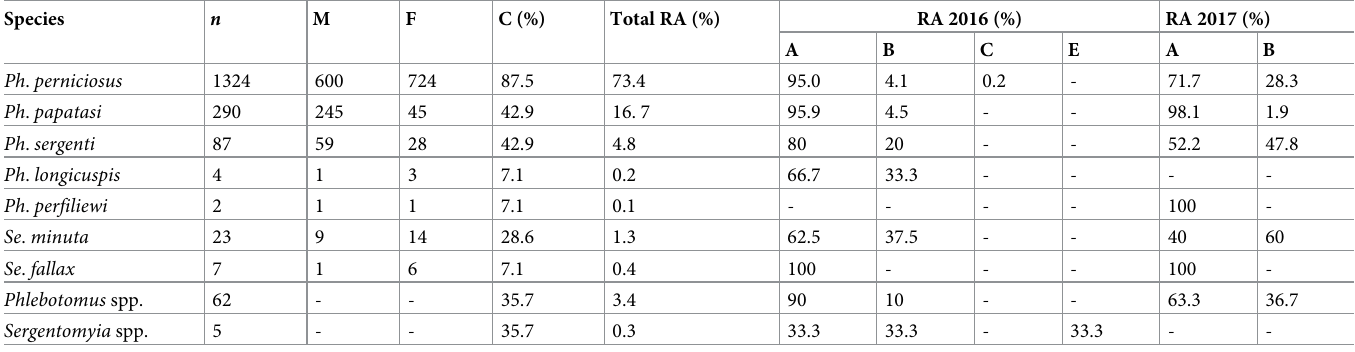
Table 2. Phlebotomine sand flies collected in Setif province, North-Eastern Algeria, 2016–2017, according to species, sex, pattern of occurrence (C) and relative abundance (RA). Species n M F C (%) Total RA (%)